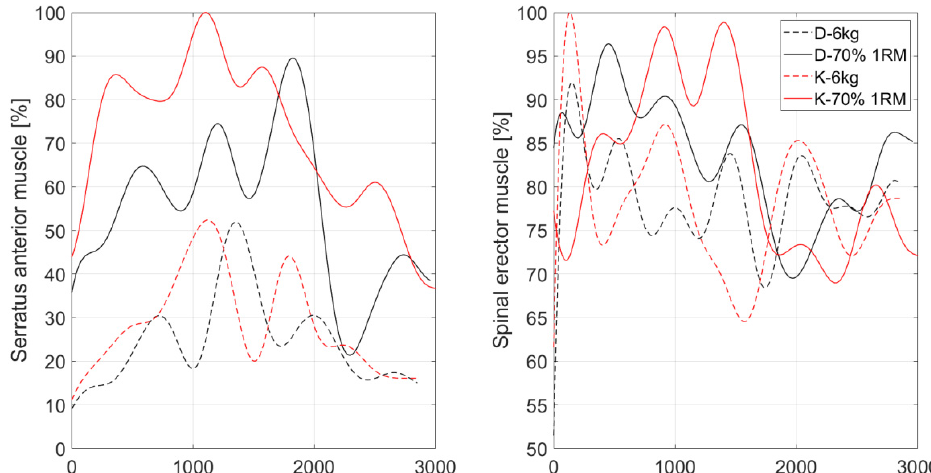
Figure 5. Example waveform of normalized muscle activity for serratus anterior and spinal erector muscles, where: D-6kg—6 kg dumbbell press, K-6kg—6 kg kettlebell press, D-70% 1RM—70% of the